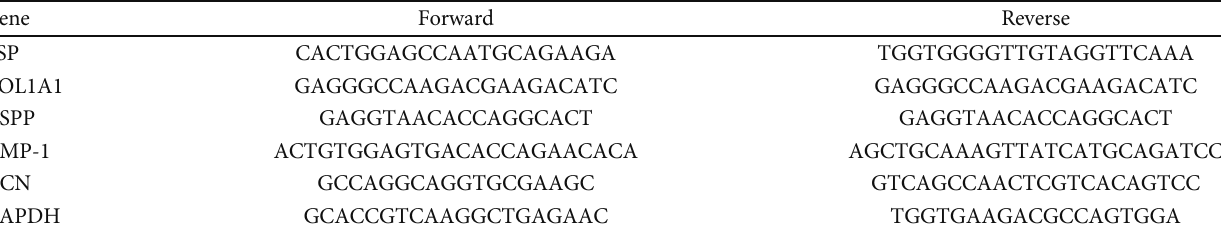
Table 1: Primers sequence for real-time